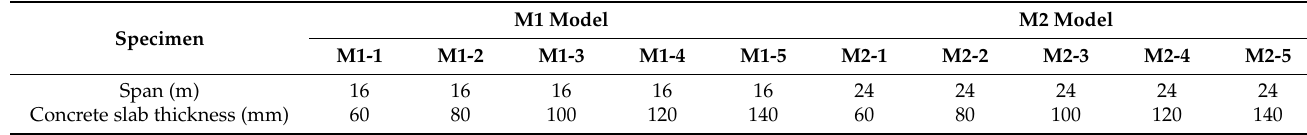
Table 6. Model parameters.